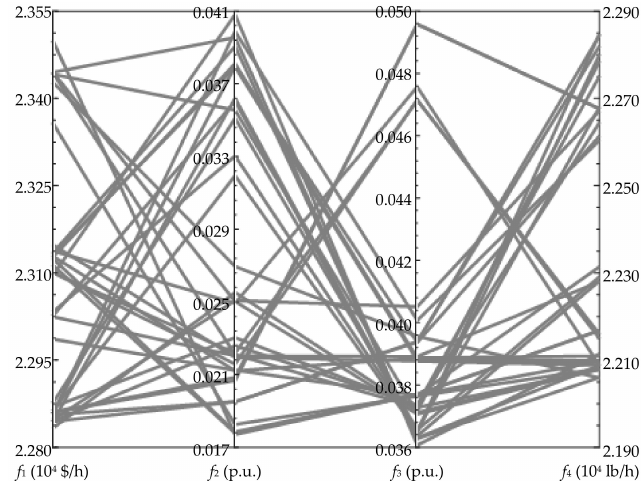
Figure 4. Distribution of Pareto-optimal solutions of non-dominated sorting genetic algorithm III